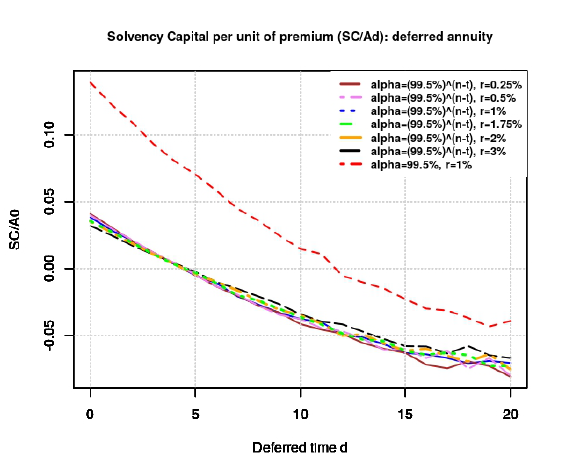
Figure 4. Deferred annuity; SC ( d ) / A t at t = d for different values of the short rate r and α on the payment period.